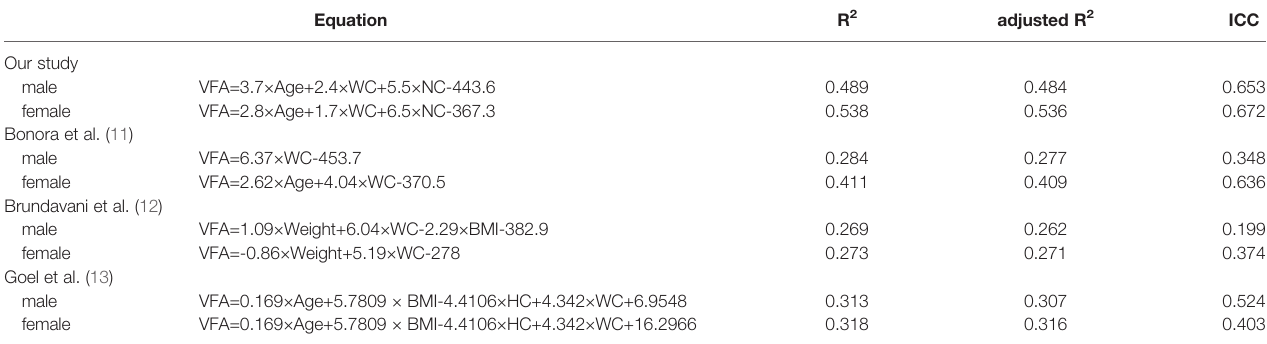
TABLE 4 | | The validation of the equations from our study and other studies.